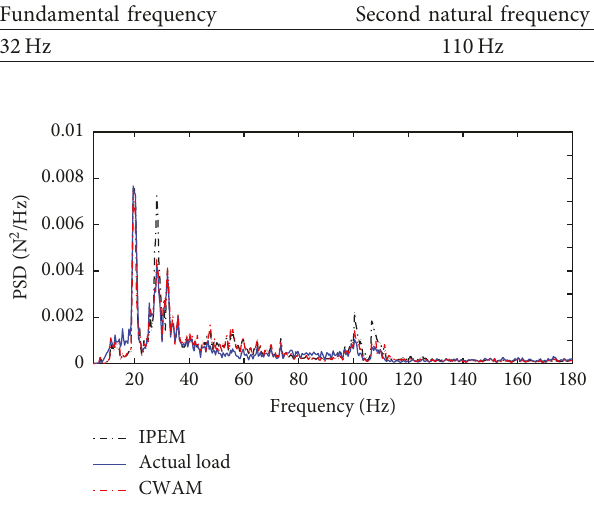
Figure 10: Identification results of excitation 1.